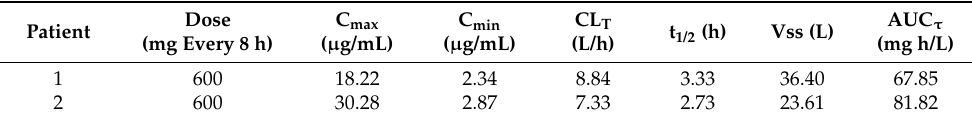
Table 6. Pharmacokinetic parameters of ceftaroline in the two critically ill patients receiving 600 mg every 8